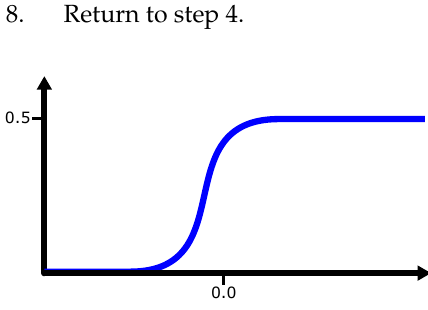
Figure 13. The sigmoid function.